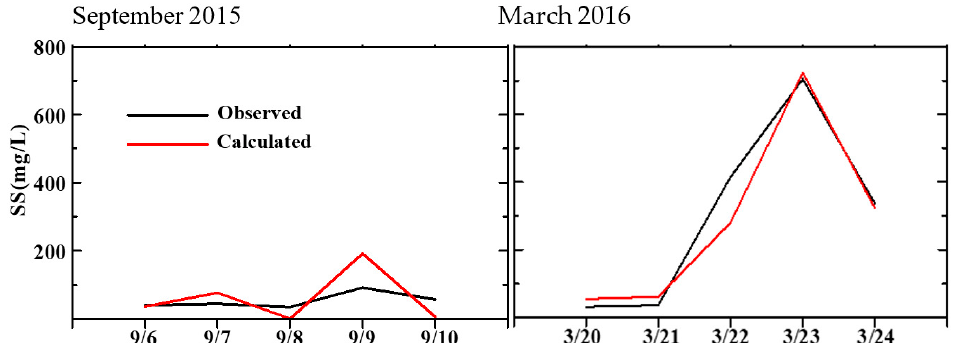
Figure 22. The daily average of the concentration of SS in the lake in the observed periods estimated from wind velocity data.